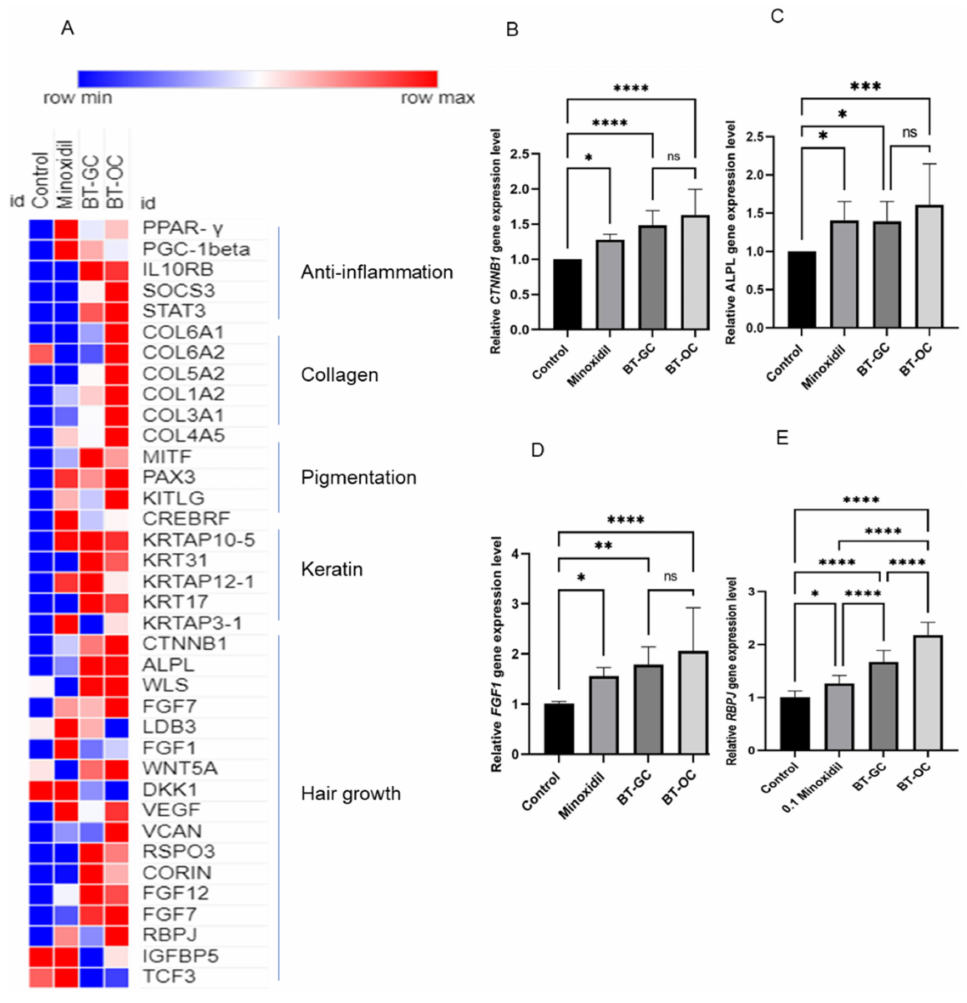
Figure 4. Enriched molecular functions’ categories by BT-GC and BT-OC and validation by gene expression. ( A ) Heatmap displaying the relative expression levels of DEGS. This is a comparison between BT-GC, BT-OC, minoxidil, and control. Several biological functions like anti-inflammation, collagen, pigmentation, keratin, and hair growth were chosen to be displayed using this heatmap generated by the online tool Morpheus Broad Institute. Gene expression of ( B ) CTNNB1 , ( C ) ALPL , ( D ) FGF1, and ( E ) RBPJ . There is no significant difference between BT-GC and BT-OC. The result represents the mean ± SD from three independent experiments. An ANOVA test (Tukey’s multiple comparison test) was used to assess the level of significance between the groups. * Statistically significant ( p -value ≤ 0.05), ** statistically significant ( p -value ≤ 0.01), *** statistically significant ( p -value ≤ 0.001), **** statistically significant ( p -value ≤ 0.0001), ns (not